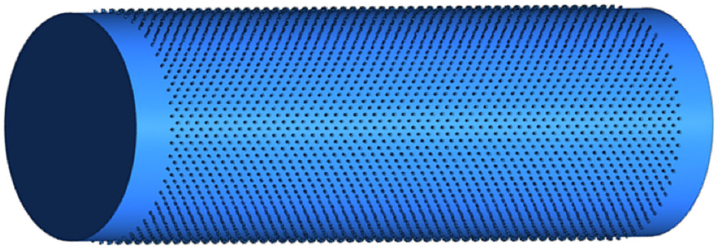
Figure 4. Three-dimensional anatomical model of xylem vessels of Khaya grandifoliola Figure 4. Three ‐ dimensional anatomical model of xylem vessels of Khaya grandifoliola .